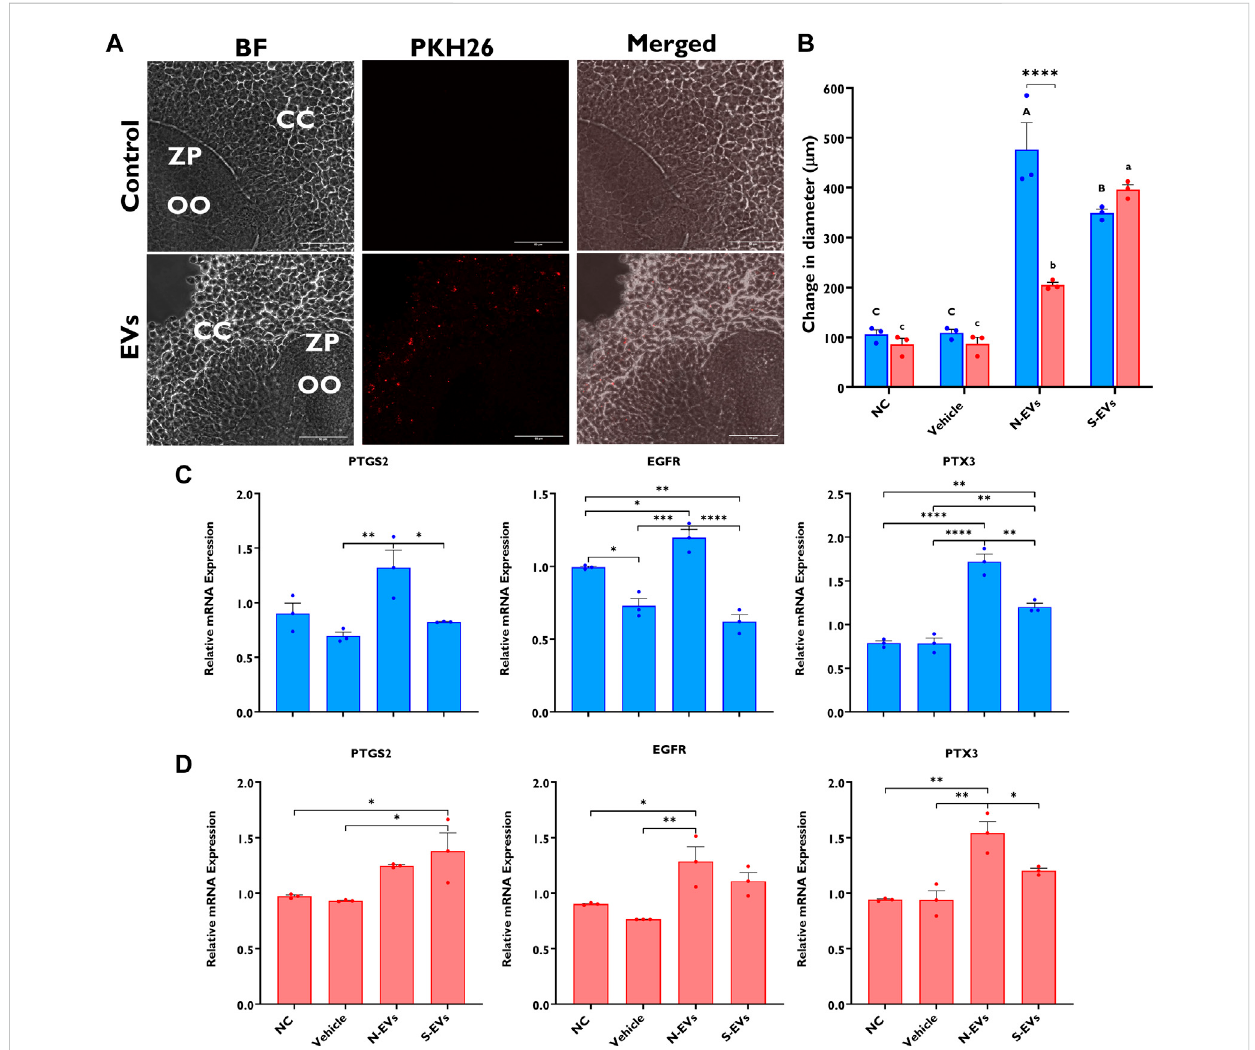
FIGURE 2 Effects of GC-EV supplementation on receptivity of follicular cells EV uptake following maturation at 38.5 ° C (blue) and 41 ° C (red) and cumulus expansion. Confocal images of intact cumulus-oocyte complexes co-incubated with PKH26 labeled GC-EVs for 24 h during in vitro maturation. Scale bar, 50 µM (A) . Follicular cell uptake of PKH26 labeled EVs is shown in the surrounding cumulus cells (CC), in relation to the oocyte (OO) and respective zona pellucida (ZP). Measurements for cumulus expansion were obtained before and after maturation using the Olympus Cellsens software. The increase in diameter was determined by subtracting the mean diameter before maturation from the mean diameter after maturation (B) . Results were carried out in four replicates (a total of 113-252 COCs per treatment). Data among treatments represent the mean±SEM and the differences between means were analyzed using Two-way ANOVA followed by Tukey ’ s Multiple Comparisons Test. Bars with different letters (38.5 ° C; uppercase) (41 ° C; lowercase) indicate statistically signi fi cant differences of at least ( p < 0.05) between treatments under the same culture conditions, while (*) indicate statistical differences between the same treatment under different culture environments during IVM (**** p < 0.0001). The expression of cumulus expansion marker geneswas assessedusing qRT-PCR fromcumuluscells isolatedfrom oocytes in triplicates (a total of50 COCs pertreatment) cultured underthermoneutral (C) andheatstress (D) conditions.Dataamongtreatmentsculturedunderthesameenvironmentrepresentthemean±SEMandthe differences between means were analyzed using One-way ANOVA followed by Tukey ’ s Multiple Comparisons Test. (* p < 0.05), (** p < 0.01), (*** p